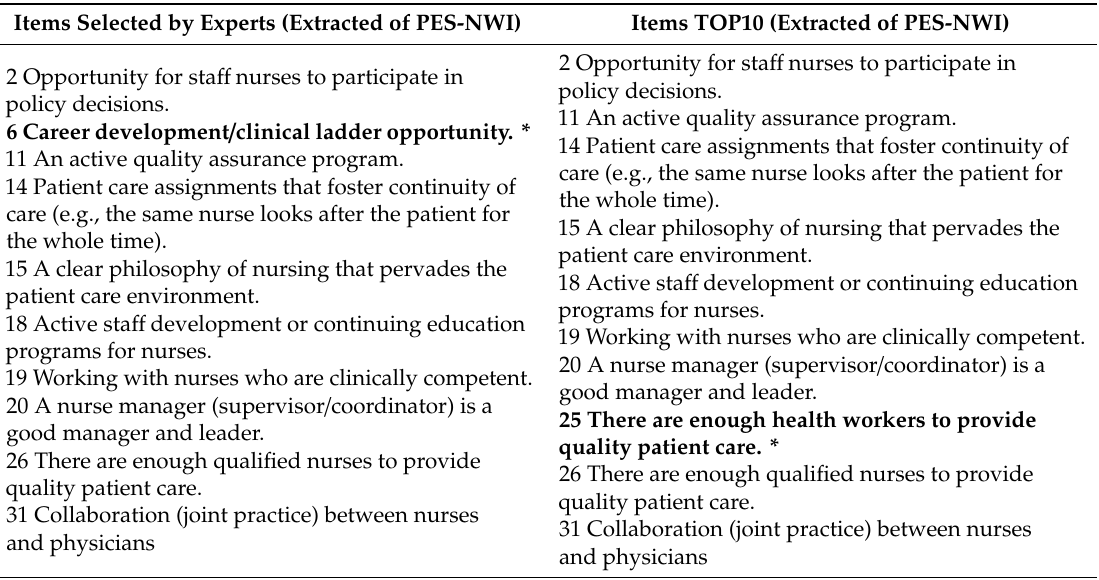
Table 5. Di ff erences in the elements selected between expert nurses and those proposed in the TOP10. Items Selected by Experts (Extracted of PES-NWI) Items TOP10 (Extracted of